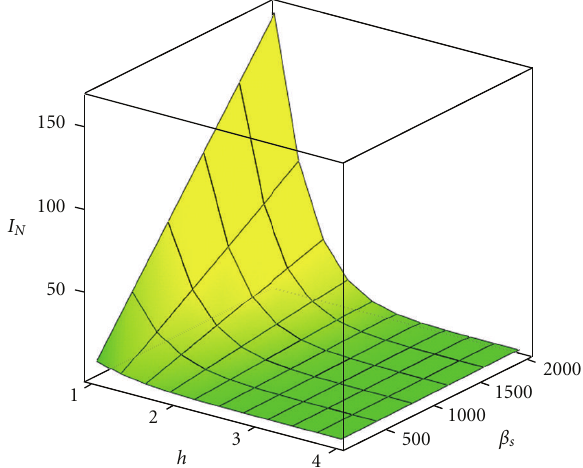
Figure 6: I N ( h , β s ) for w c = 1 ( ψ = 1), Elastic-Plastic Range (1).